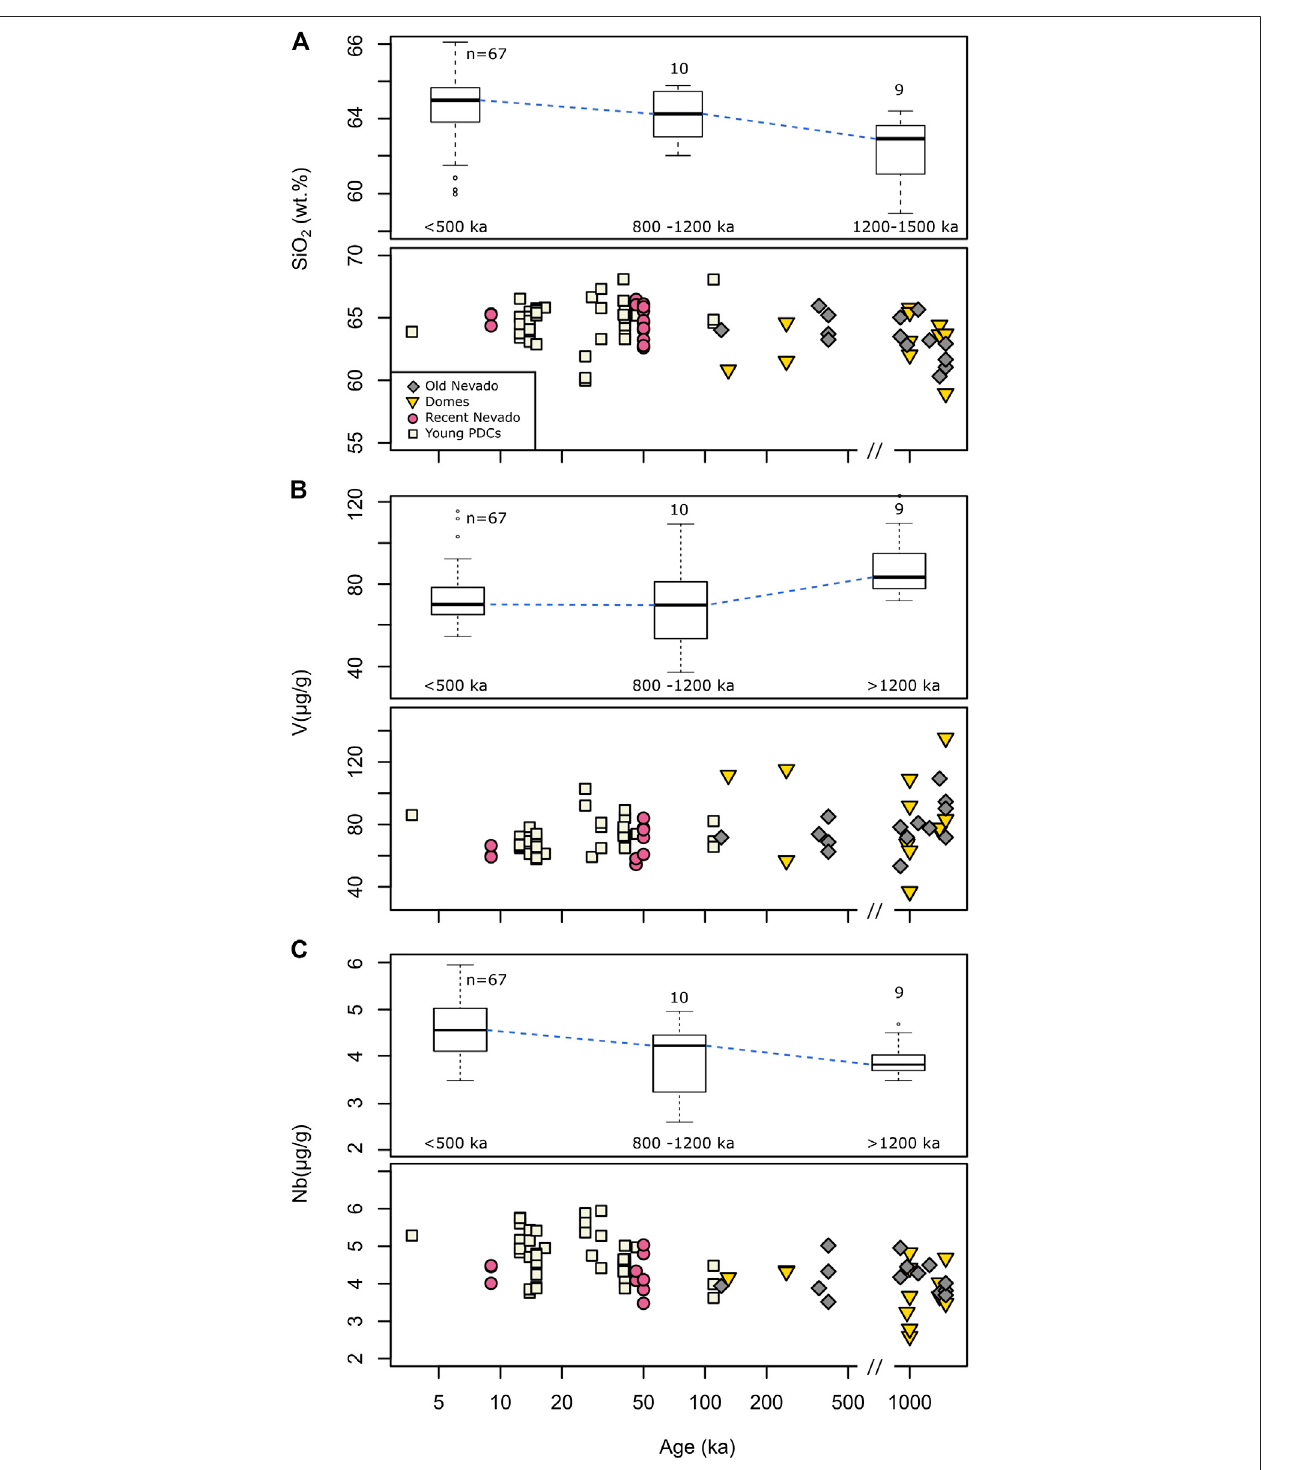
FIGURE 10 | Time variation of SiO 2 (wt%), V (µg/g), and Nb (µg/g) bulk-rock compositions. For each element, the upper panel shows boxplots of whole rock analysis subdivided into three age groups: < 500 ka, 800 – 1,200 ka, and 1,200 – 1,500 ka. The number of analysis for each group is indicated on top of the boxplots. Lower subpanels show the data color coded for eruptive groups: Old Nevado stage (gray rhombus), Domes (gold triangles), Recent Nevado stage (red circles), and Young Pyroclastics (beige squares). (A) Age (ka) vs. SiO 2 (wt%). (B) Age (ka) vs. V (µg/g). (C) Age (ka) vs. Nb (µg/g). A sampling gap between 400 and 860 ka is indicated on the x -axis. Note the logarithmic scale on the abscissa.